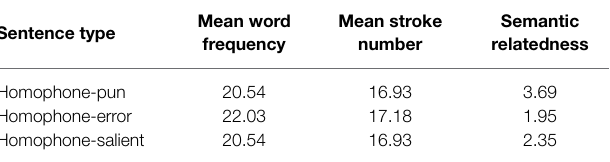
TABLE 2 | Properties of the critical context noun used in the three sentence conditions. Sentence